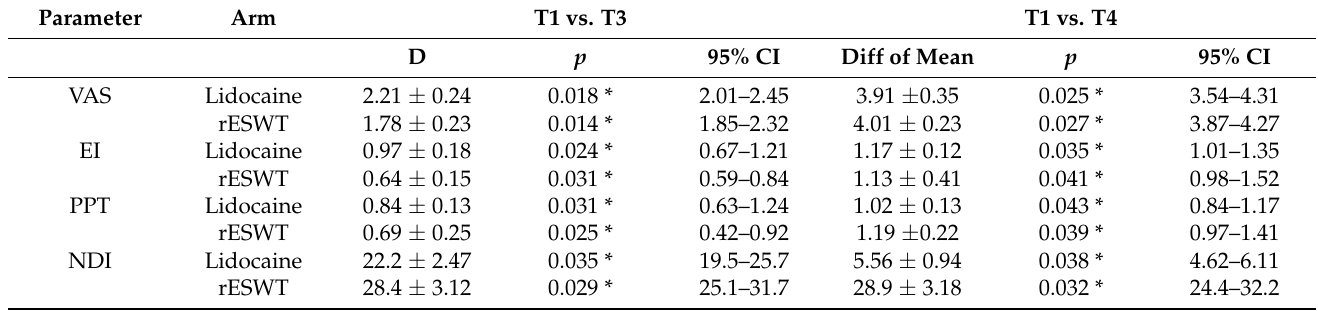
Table 3. Comparison of outcome measures within the arms (post hoc